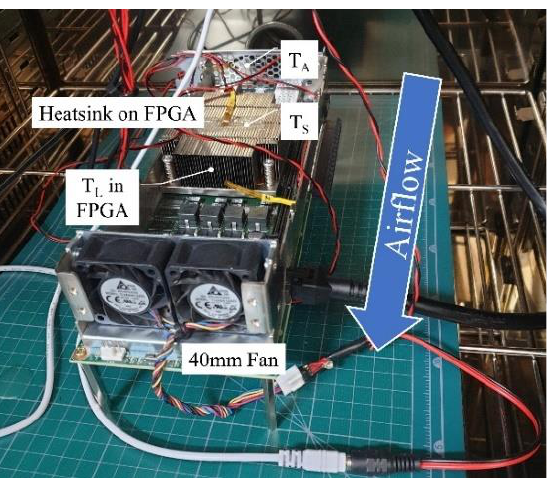
Figure 6. FPGA development kit added with the temperature sensors (airflow and its intensity are controlled using the fan).